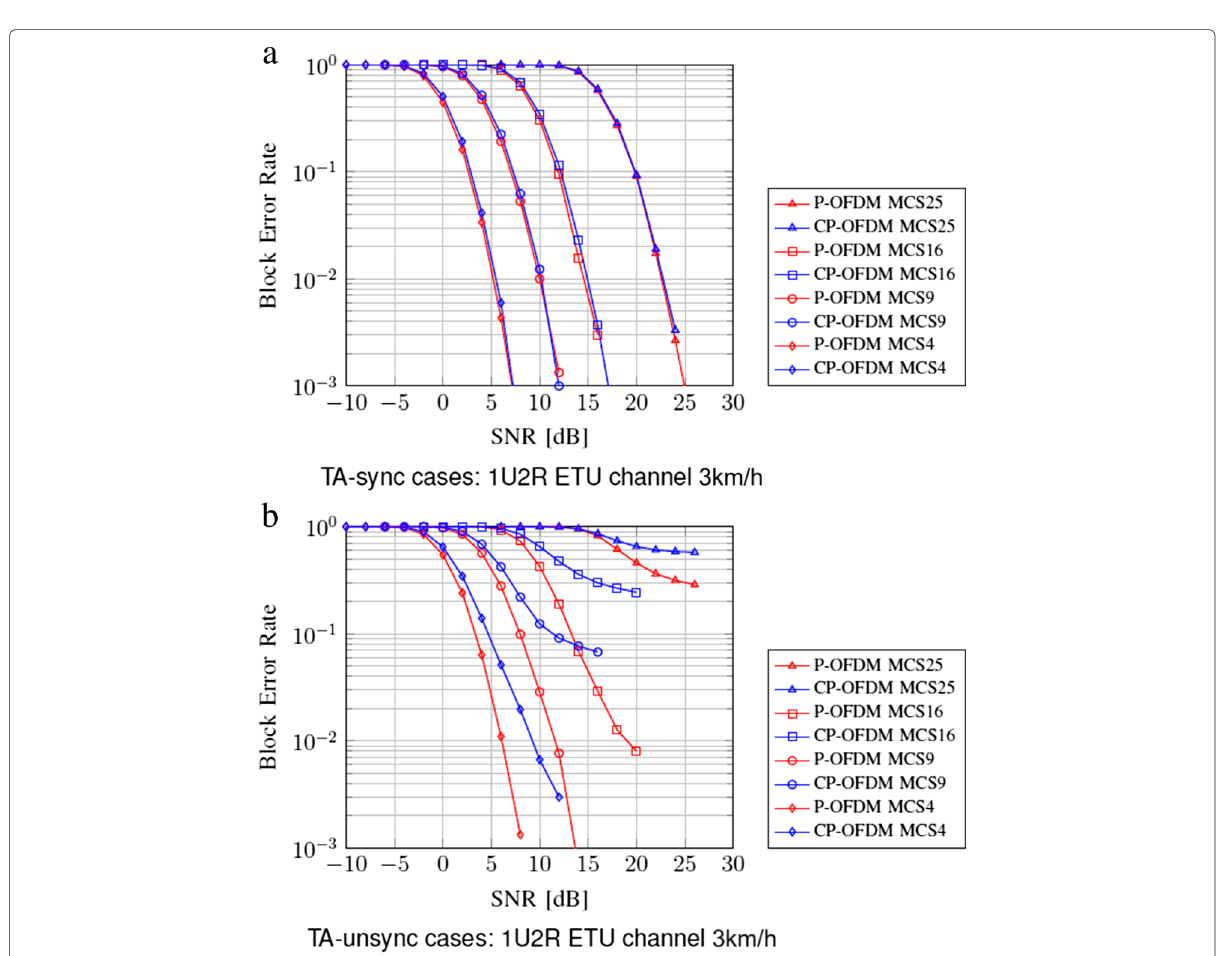
Fig. 18 a , b TA sync/unsync cases: 1U2R ETU channel 3 km/h: comparison vs.